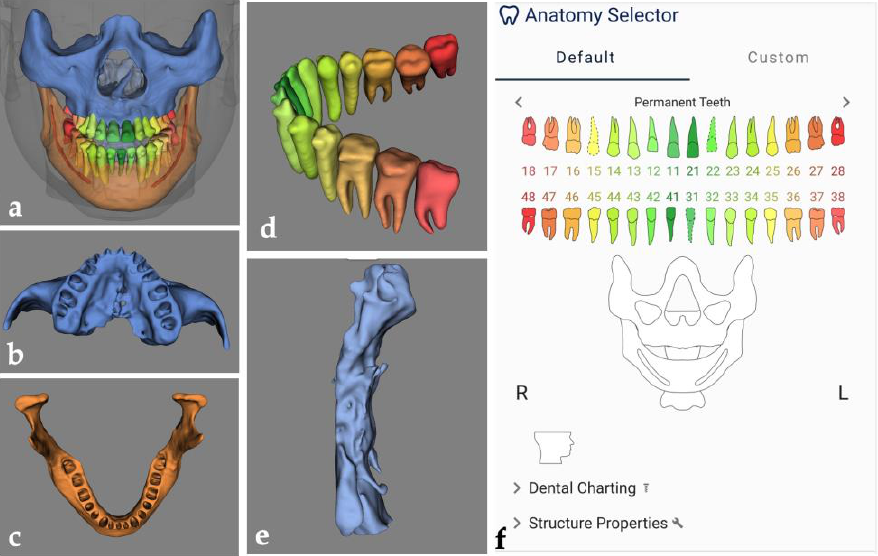
Figure 2. Example of automated segmentation of dento-maxillofacial anatomical structures on CBCT images using a commercially available AI software platform, Relu (Leuven, Belgium; available at https://relu.eu (accessed on 5 December 2022)). The overview of the segmented anatomical structures ( a ), including the maxilla ( b ), mandible ( c ), teeth with orthodontic brackets ( d ), and pharyngeal airway ( e ), and automated labeling of teeth ( f ).